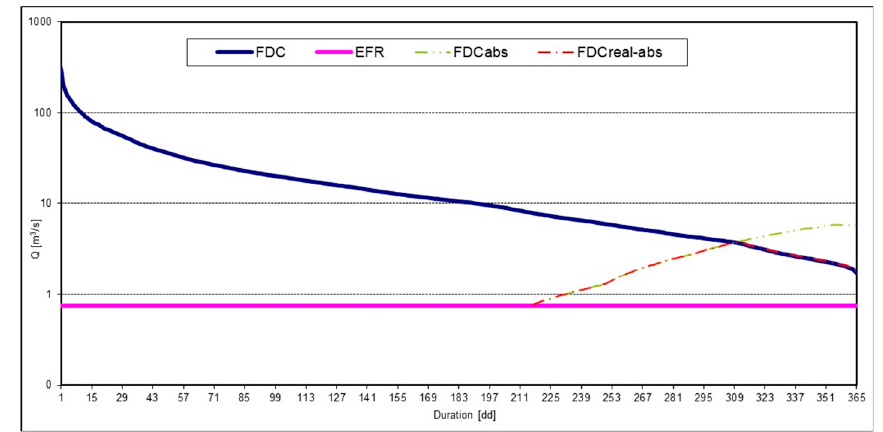
Figure 3. Flow Duration Curve (FDC), environmental flow requirement (EFR), FDC of irrigation abstractions (FDC abs ) and FDC of real irrigation abstractions (FDC real-abs ).